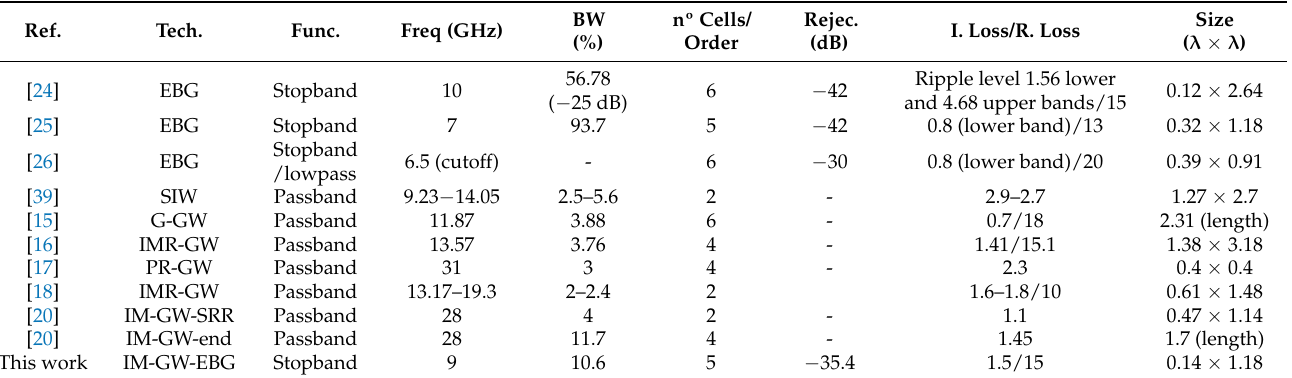
Table 1. Comparison with other filters of the state of the art. Tech: Technology and type, Func: Filter functionality, BW: Fractional bandwidth (rejection above 20 dB for stopband and 3-dB FBW for passband filters), Rejec: Max rejection level for stopband filters, I. Loss/R. Loss: Insertion loss and return loss in the passband, Size: 2D size for filter in guided